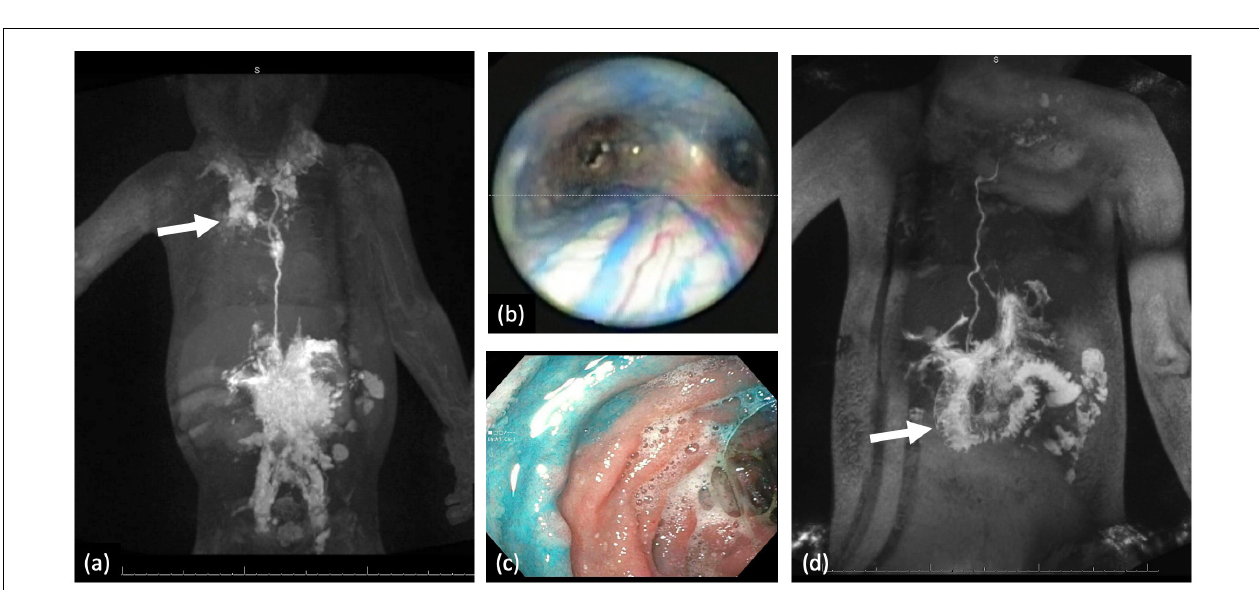
FIGURE 4 | (a) MIP coronal projection of IN-DCMRL demonstrating mediastinal and bilateral PLPS more on the right (arrow). (b) In a patient with PB blue dye injection into the TD demonstrated dilated peribronchial lymphatic networks. (c) Blue dye injection into the liver demonstrating leak into the duodenal lumen. (d) MIP coronal projection of IH-DCMRL demonstrating leak into the duodenal lumen characteristic of PLE (arrow).